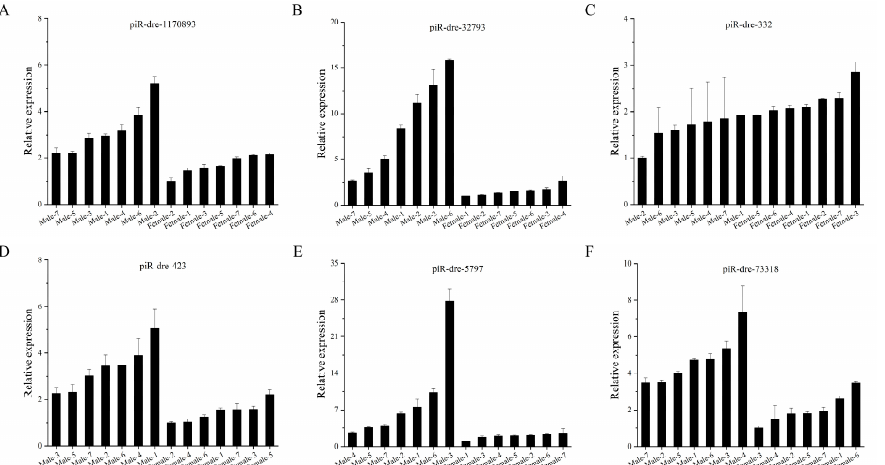
Figure 5. Real-time quantitative polymerase chain reaction verification of the expression of six piwi-interacting RNAs in serum exosomes from seven male and seven female greater amberjack. The x -axis represents each fish from the male and female group, and the y -axis represents the relative expression levels of piwi-interacting RNAs in each fish. Data are presented as the mean ± SD, n = 3. ( A ) piR-dre-1170893. ( B ) piR-dre-32793. ( C ) piR-dre-332. ( D ) piR-dre-423. ( E ) piR-dre-5797. ( F ) piR-dre-73318.